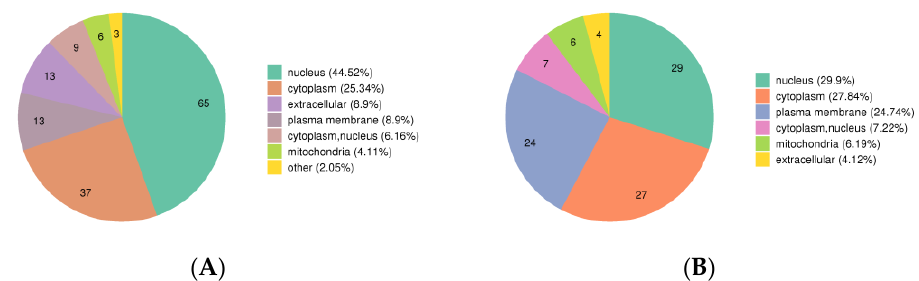
Figure 2. The subcellular structure localization classification of DPPs. ( A ) up-regulated DPPs. ( B ) down-regulated DPPs. Different colors indicate different subcellular structures. The number in the pie chart indicates the number of DPPs located in the subcellular structure.